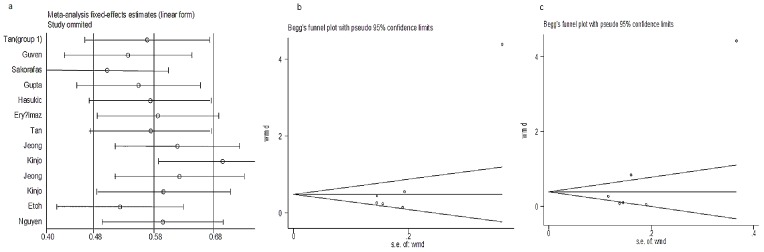
a. Sensitivity analysis. b. Funnel plot analysis to detect publication bias for ALT results on postoperative day 3; each point represents a separate study for the indicated association. c, Funnel plot analysis to detect publication bias for AST results on postoperative day 3; each point represents a separate study for the indicated association.